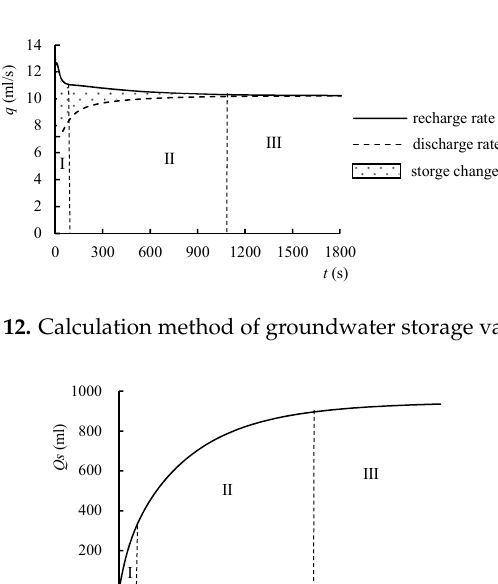
Figure 13. The ESC ( Q s )—time ( t ) relationship curves.